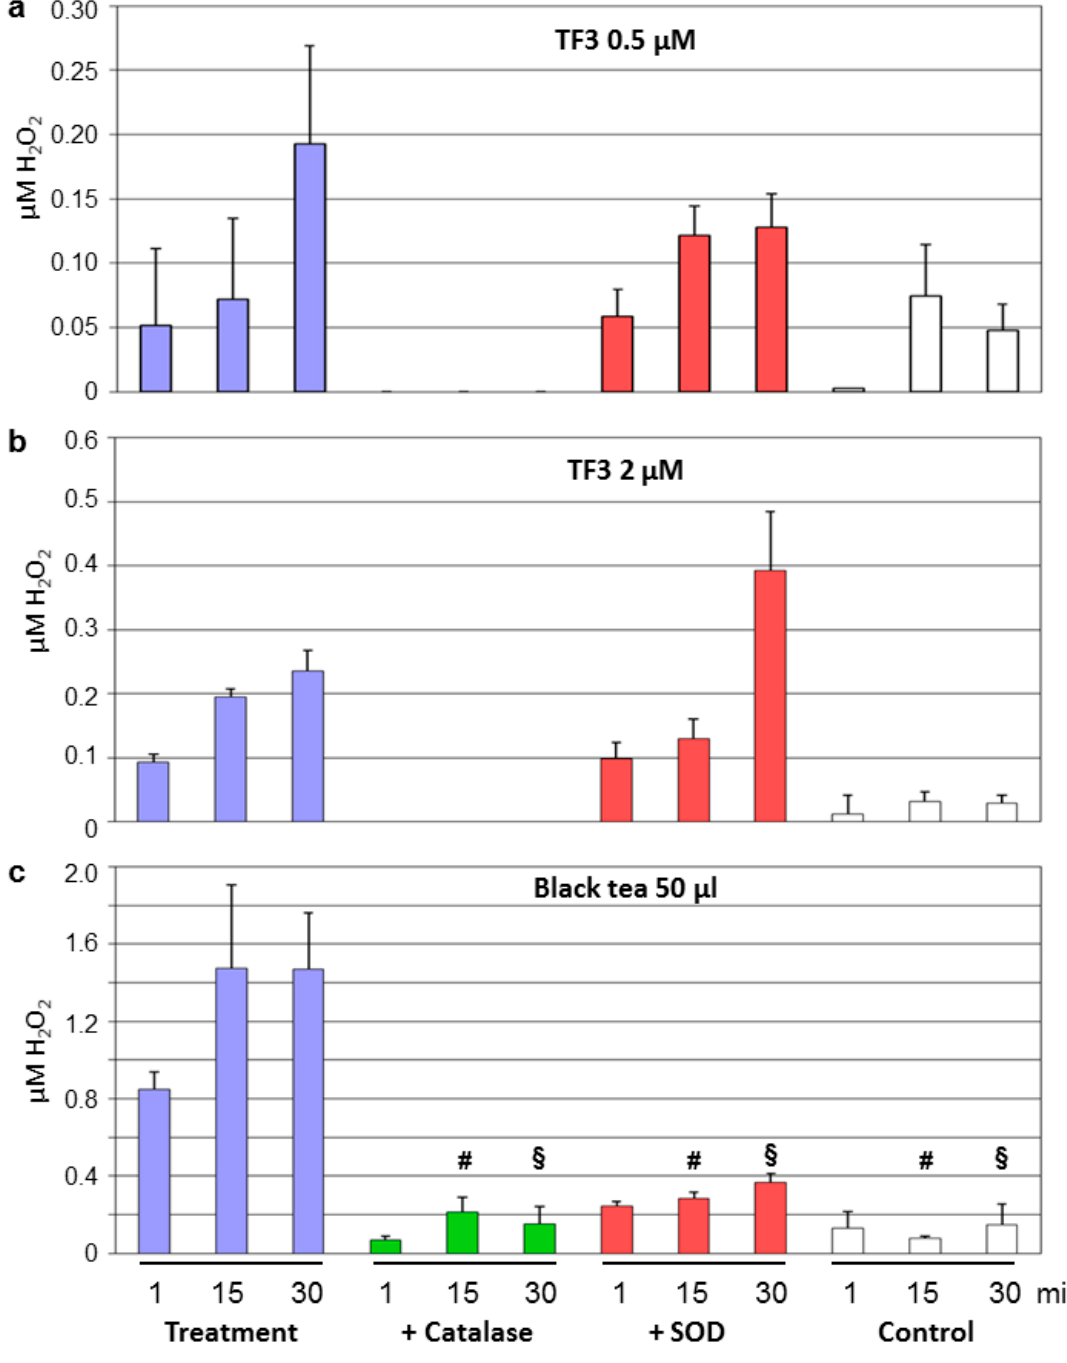
Figure 5. Black tea polyphenols generate H 2 O 2 . A single dose of TF3 (0.5 µM ( a ) or 2 µM ( b ) or of 50 µ L black tea ( c ) was applied. Aliquots were taken after the indicated time points and concentrations of hydrogen peroxide in the Krebs–Henseleit bu ff er were determined. Experiments were performed with or without 200 U / mL catalase or 500 U / mL superoxide dismutase (SOD). Krebs–Henseleit bu ff er without any treatment served as controls. Data are means ± SEM from n = 3 experiments for TF3 and n = 4 for black tea. # p < 0.05 compared to treatment without antioxidant enzymes after 15 min; § p < 0.05 compared to treatment without antioxidant enzymes after 30 min. The H 2 O 2 levels for 0.5 and 2 µ M TF3 + catalase were below the detection